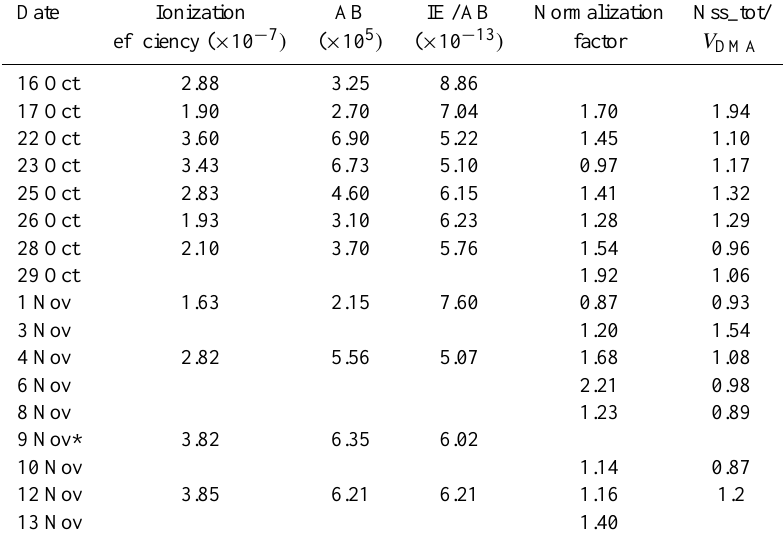
Table 2. AMS ionization efficiency (IE), Air beam counts (AB), IE/AB, normalization factor, and ratio of total mass to DMA volume. Date Ionization AB IE/AB Normalization Nss_tot/ efficiency ( × 10 − 7 ) ( × 10 5 ) ( × 10 − 13 ) factor V DMA 16